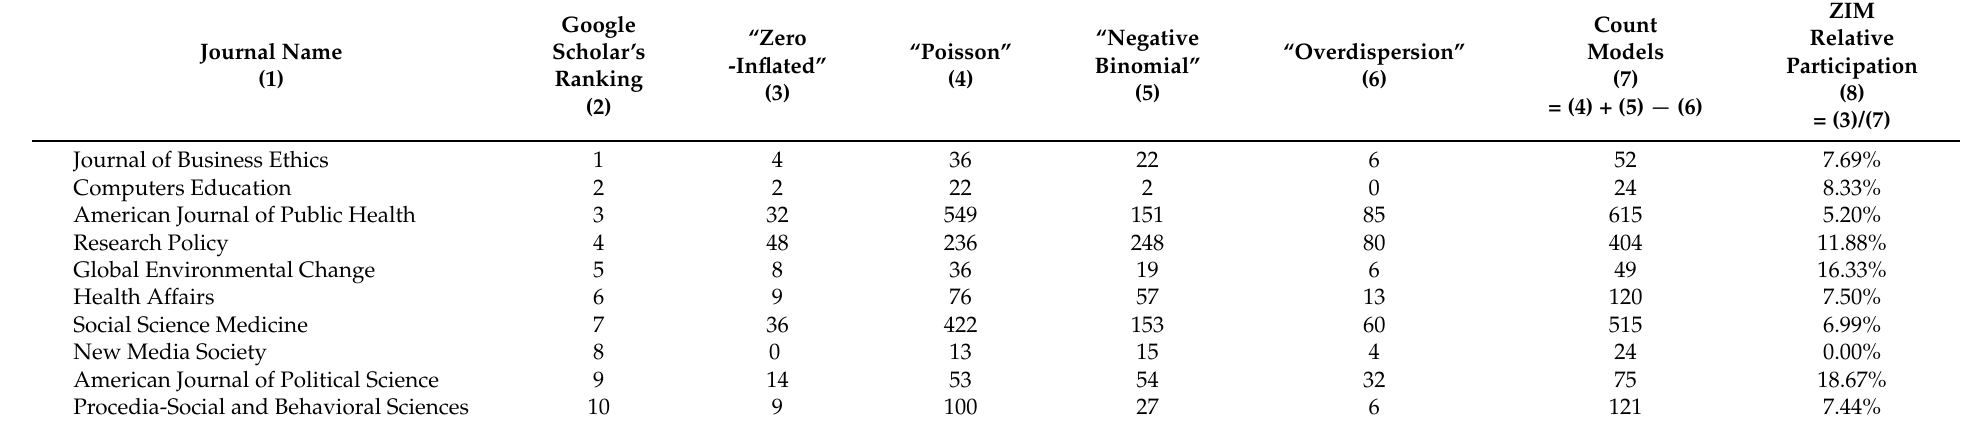
Table 1. Use of count models and zero-inflated models (ZIM) in the top 10 journals in the field of Social Sciences.